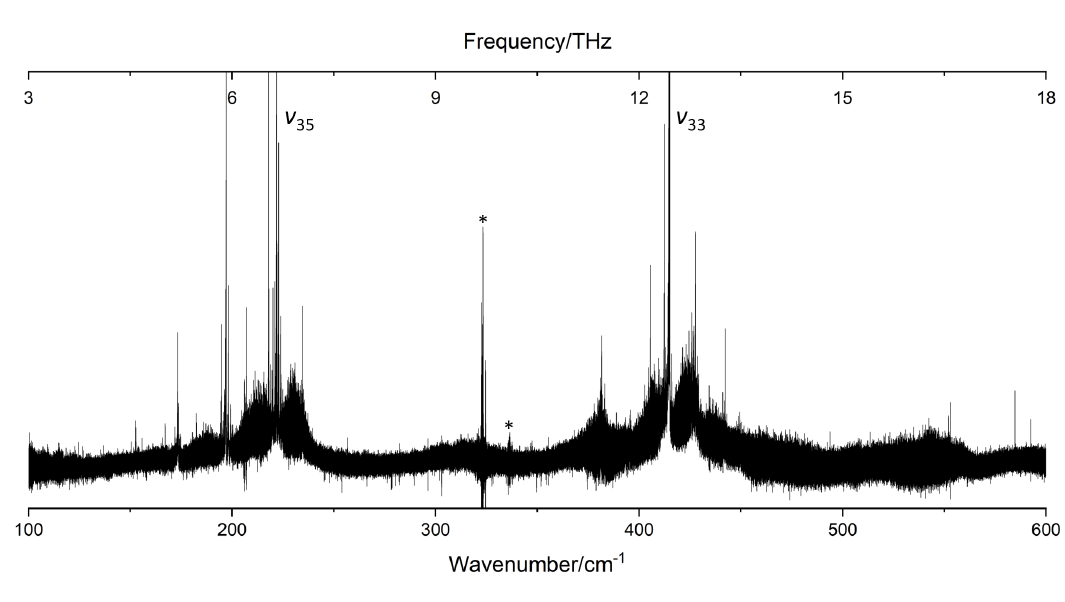
Figure 3. The FT-far-IR spectrum of catechol in the 100–600 cm − 1 range measured at high-resolution (10 − 3 cm − 1 ) at the AILES beamline of the SOLEIL synchrotron (630 scans co-added, P (cid:39) 10 µ bar and T = 300 K). ν 35 and ν 33 label the bands associated with the free and bonded -OH torsional modes involved in the intramolecular HB. Artefacts due to bad compensations with the background spectrum are marked with an